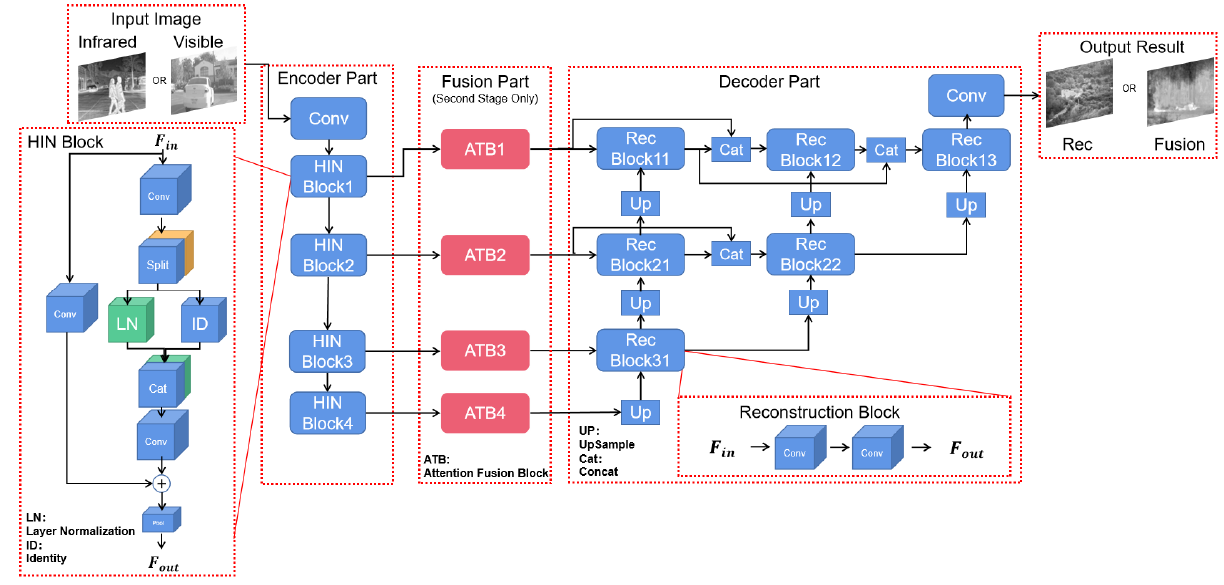
Figure 3. The detail structure of the proposed multi-stage fusion network.